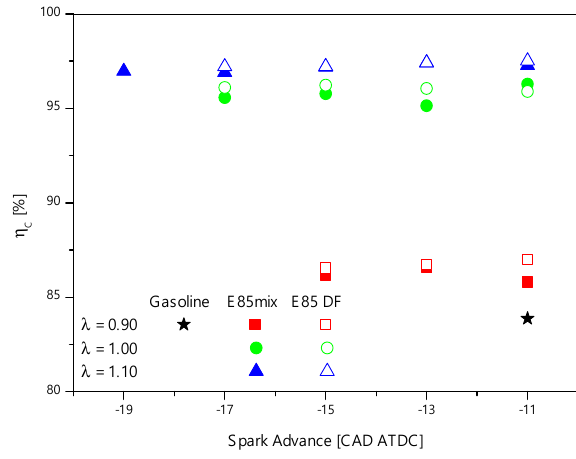
Figure 10. Combustion efficiency against the spark advance at different λ .